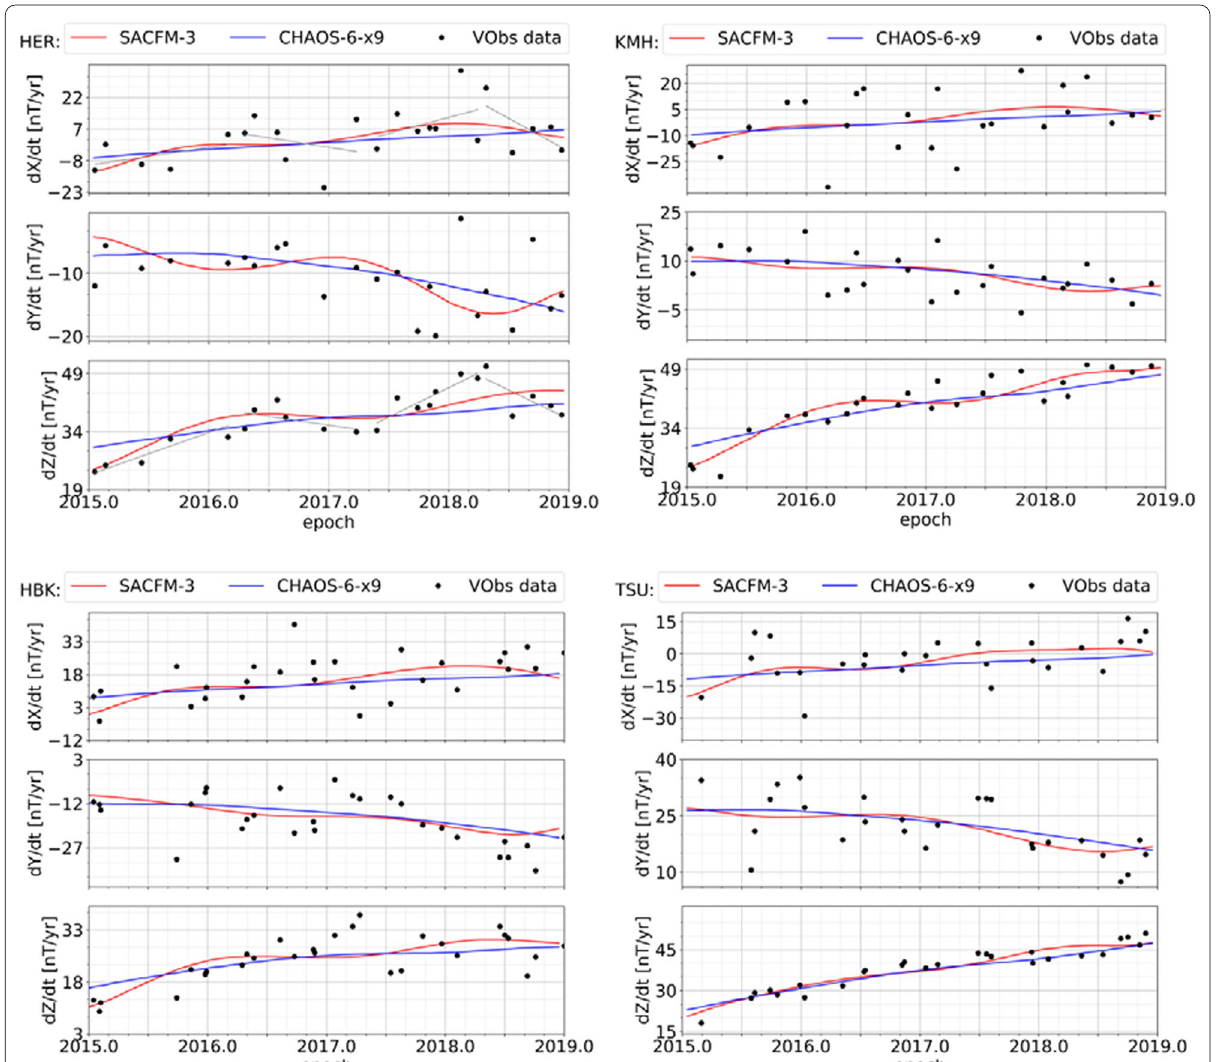
Fig. 5 The secular variation trend in X, Y and Z field components between 2015.0 and 2019.0 epochs at 476 km altitude from the virtual observatory satellite data (black dots, see text) at the positions of the INTERMAGNET stations HER, HBK, TSU and KMH and the models SACFM-3 (red) and CHAOS-6- 9 (blue). Gray lines represent piecewise linear fits to highlight abrupt changes of ×